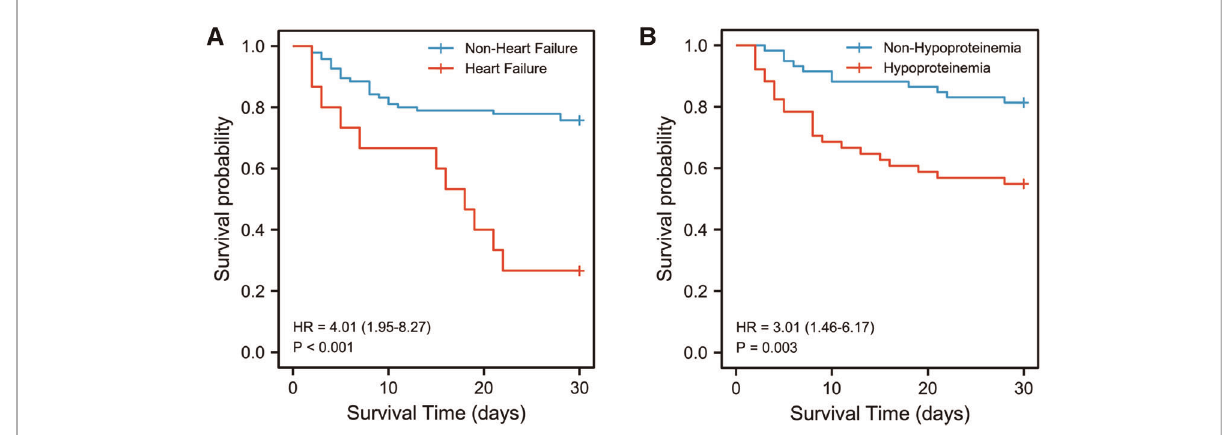
FIGURE 2 Kaplan-Meier survival estimates of survival rate. ( A ) Kaplan-Meier survival estimates of survival rate in 110 patients with or without heart failure. ( B ) Kaplan-Meier survival estimates of survival rate in 110 patients with or without